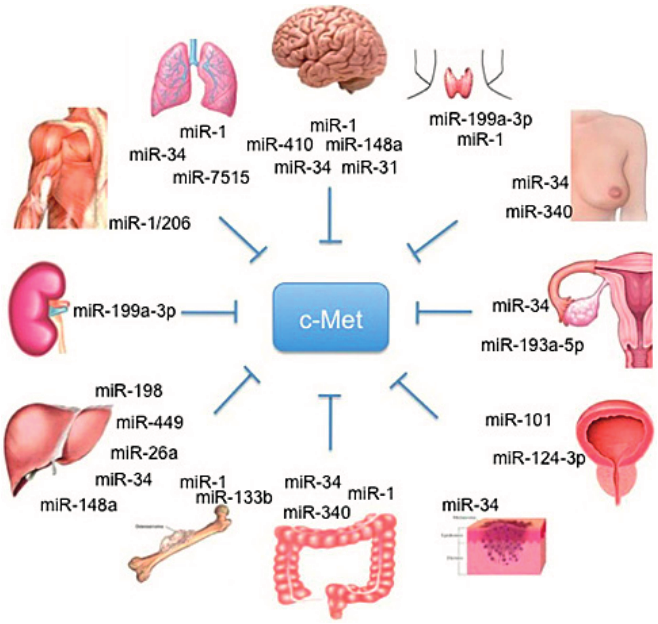
Figure 1. Schematic representation of organ-specific miR involved in HGF/c-MET